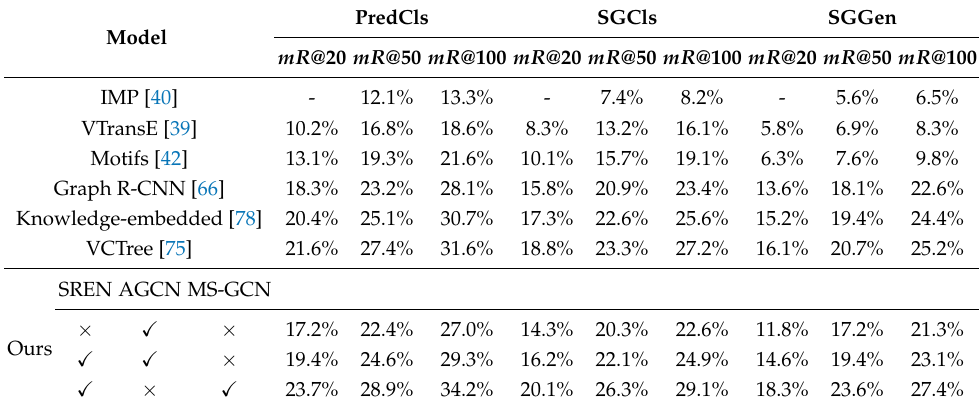
Table 3. Experimental results on